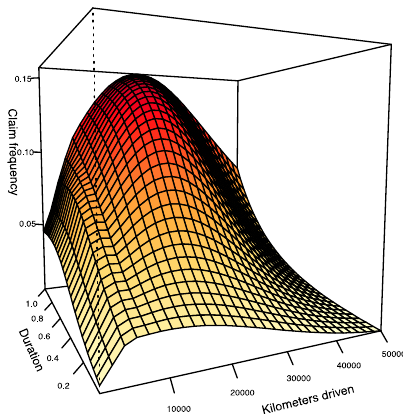
Figure 7. Model 1—Predictions surface (angle 1).